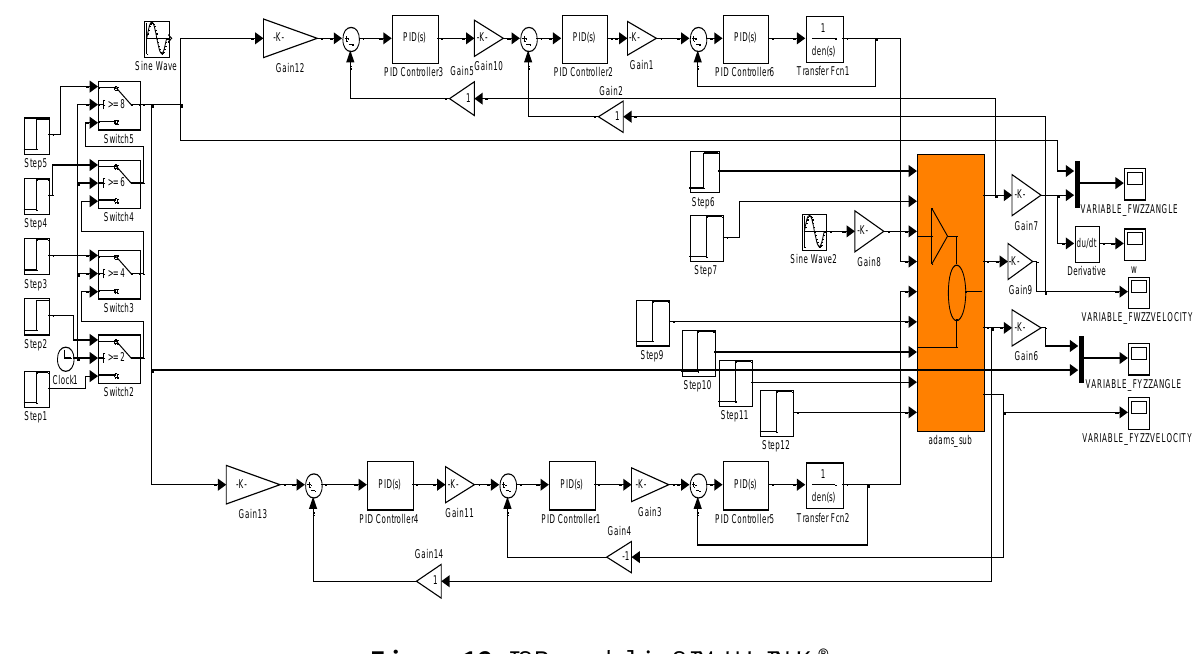
Figure 12. ISP model in SIMULINK ® .